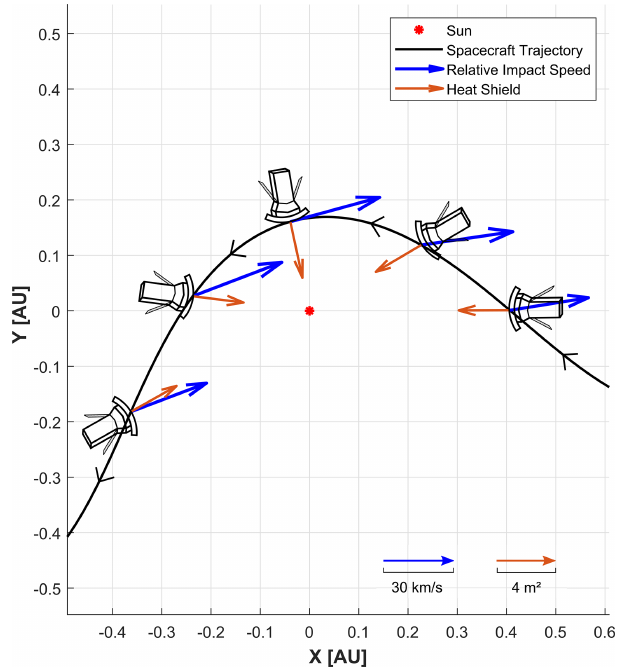
Figure 12. Parker Solar Probe trajectory during first perihelion pas- sage. Blue arrows indicate speed of spacecraft relative to the dust particles in circular orbit. Red arrows indicate the surface vector of the spacecraft heat shield. Figure courtesy of Calvinhac (2019).